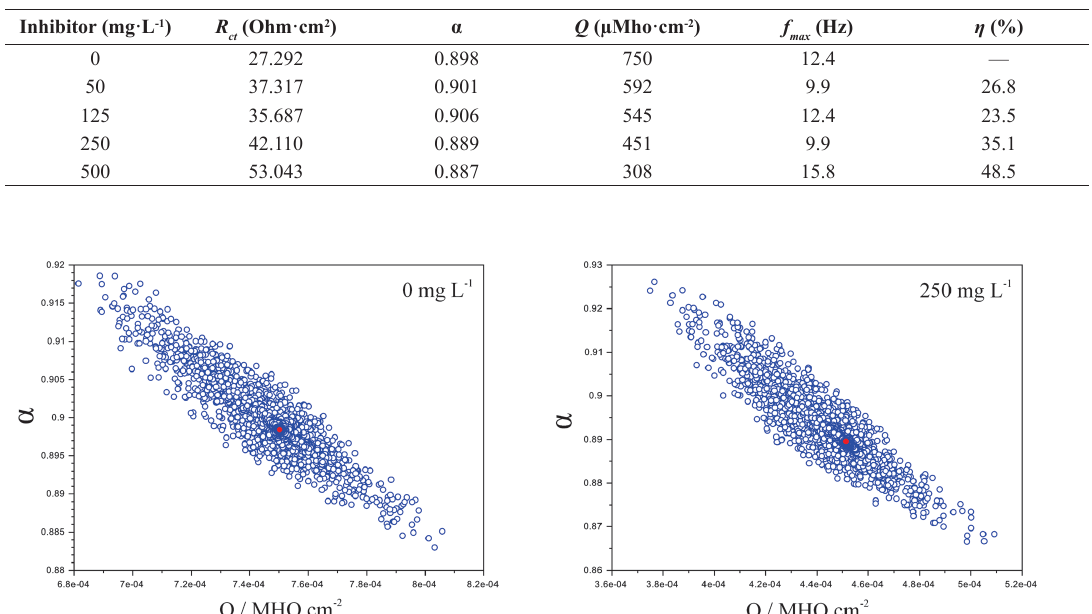
SO with and without methanolic Bauhinia 2 4